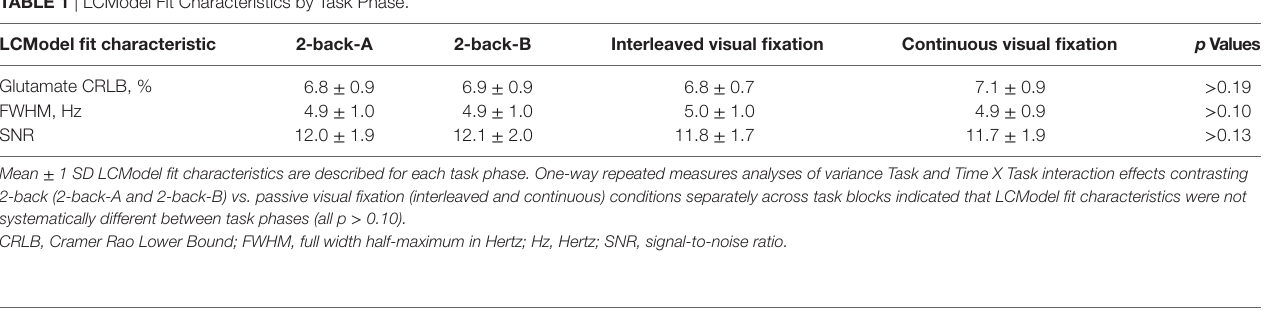
TaBle 1 | LCModel Fit Characteristics by Task Phase.